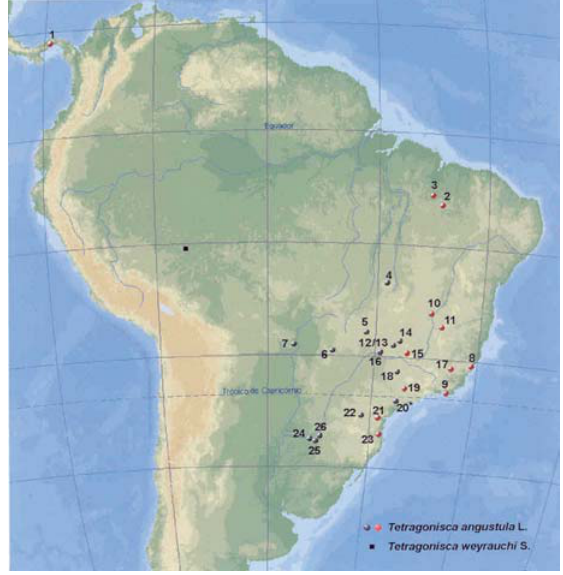
Figure2 -Geographicdistributionofthetwo T.angustula clusters:Group 1 (red) includes: 1- Panama, 2- Mirador, 3- Barra do Corda, 8- Domingos